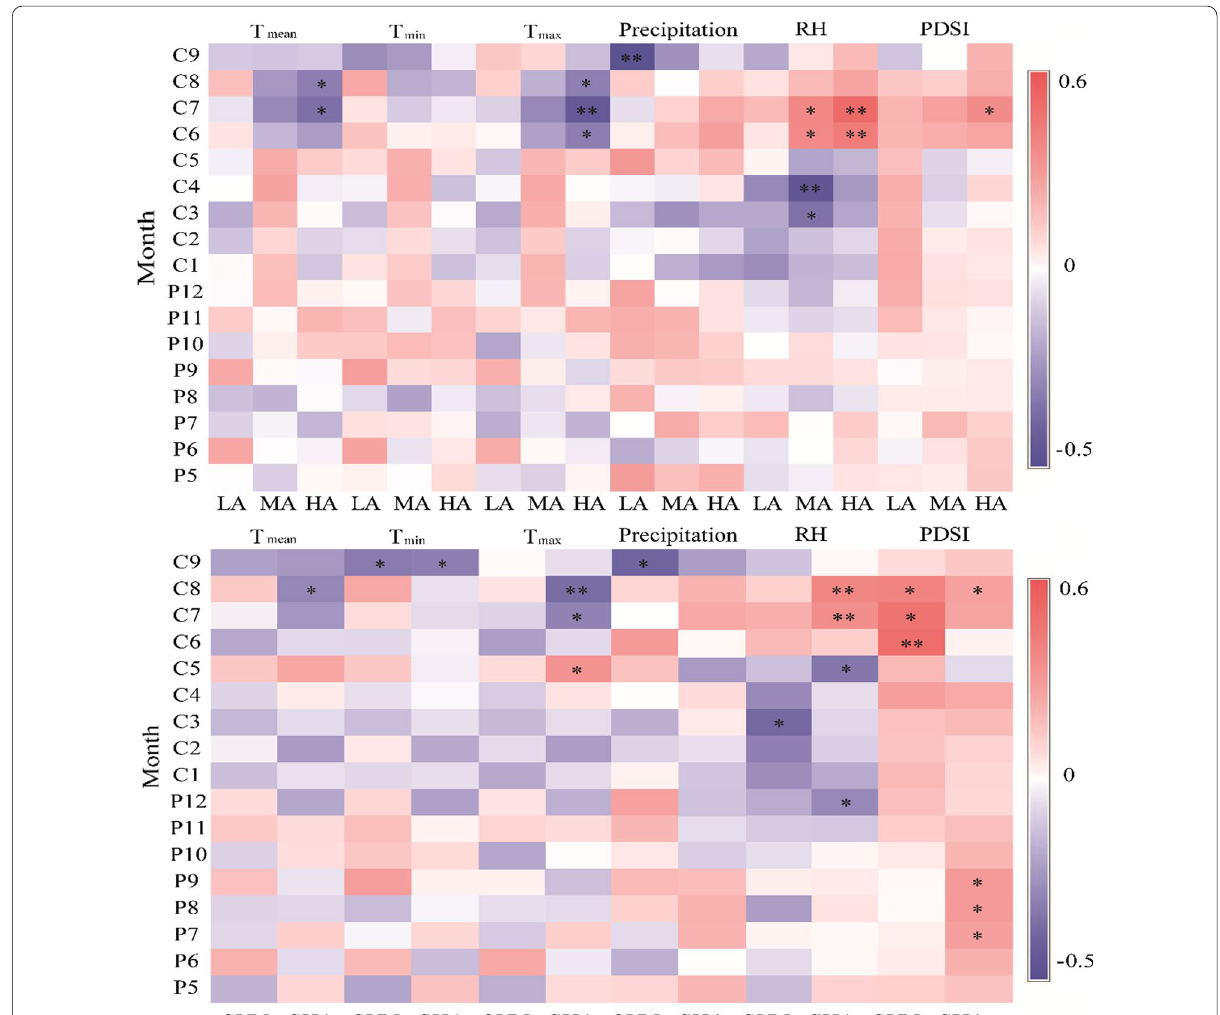
Fig. 8 Response of radial growth of L. olgensis to monthly climatic factors at different altitudes (the upper half) and slopes (the lower half). The capitalized P means months from the past year and C from the current year. The gradual change of color from blue to red indicates a gradual change of correlation from negative to positive. * p < 0.05; ** p <